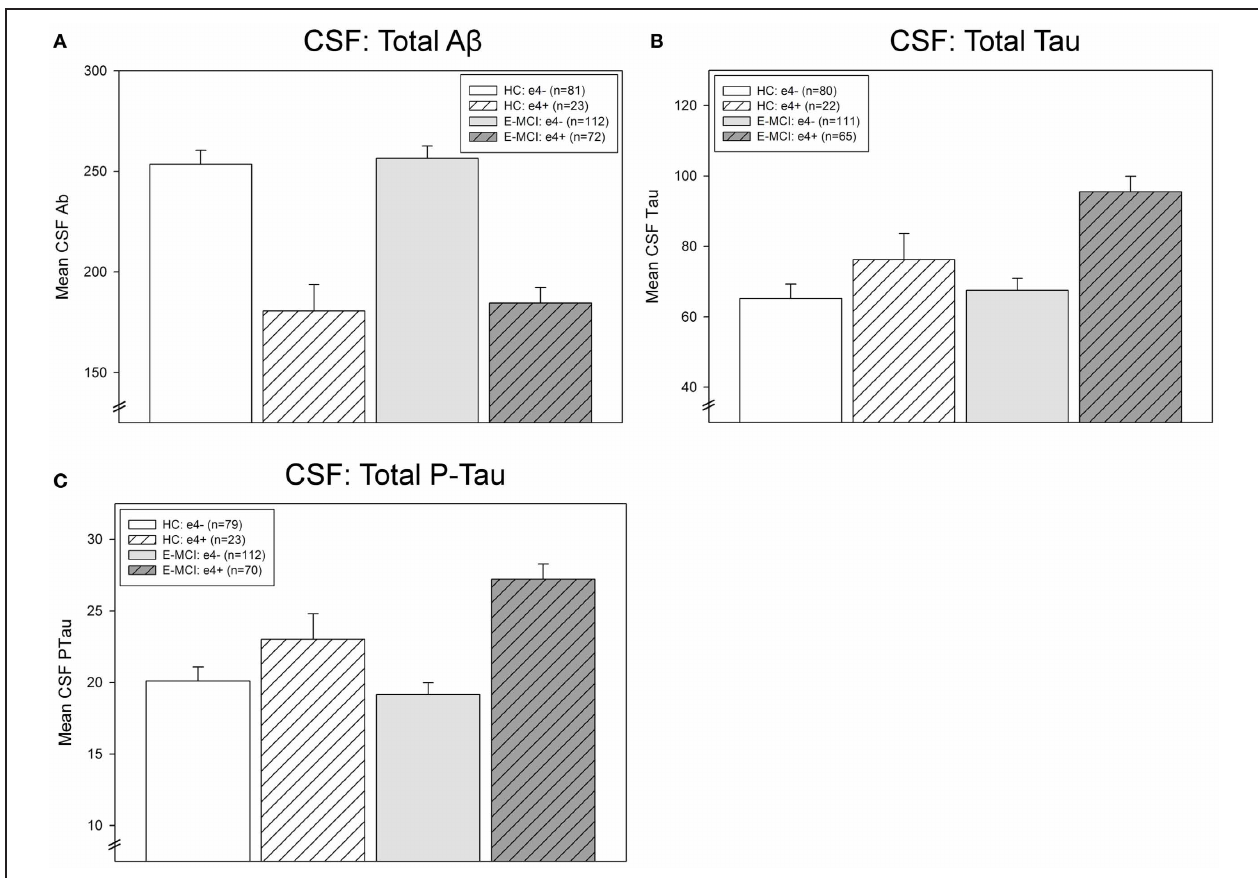
levels than HC participants and APOE ε 4 + showing higher levels than APOE ε 4 − participants. Finally, an interaction between diagnostic status and APOE ε 4 status on CSF p-tau levels was also observed ( p < 0 . 05), primarily driven by a higher level of p-tau in APOE ε 4 + HC and E-MCI participants relative to APOE ε 4 − HC and E-MCI participants. The total number of participants in each analysis is shown for each graph (Panels A–C ). Note: See text for description of participants excluded from the CSF